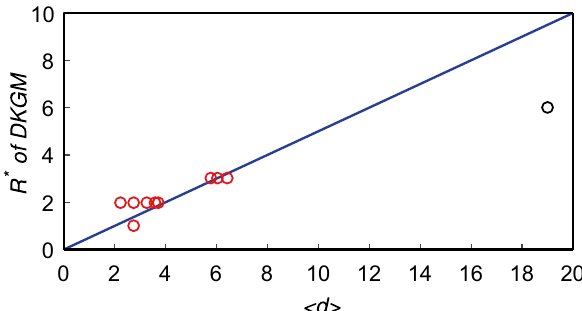
Figure 3. The relation between R ∗ of DKGM and (cid:31) d (cid:30) for β = β c . Ten circles represent ten real networks and the slope of the blue line is 1/2. The black circle is the Power network. Although the optimal truncation radius R ∗ = 6 in the Power network is slightly different from what Eq. 4 predicts (i.e., R = 9 ), the algorithmic accuracy at R = 9 ( τ = 0.7366 ) is very close to the best accuracy at R ∗ = 6 ( τ = 0.7575 ).